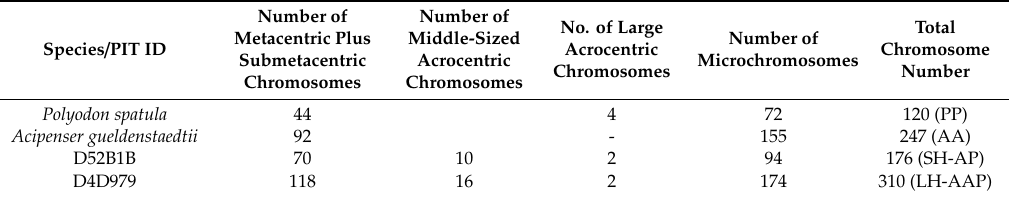
Figure 2. Mitotic metaphase chromosome spread ( A ) from fibroblast cell culture of the pectoral fin of an LH (large genome size hybrids) individual (No. D4D979). ( B ) Corresponding karyotype of A. gueldenstaedtii. x P. spathula. pentaploid hybrid. Red arrows show the paternal ‐ originated two large acrocentric chromosomes from P. spathula. Bar 5 μ m.